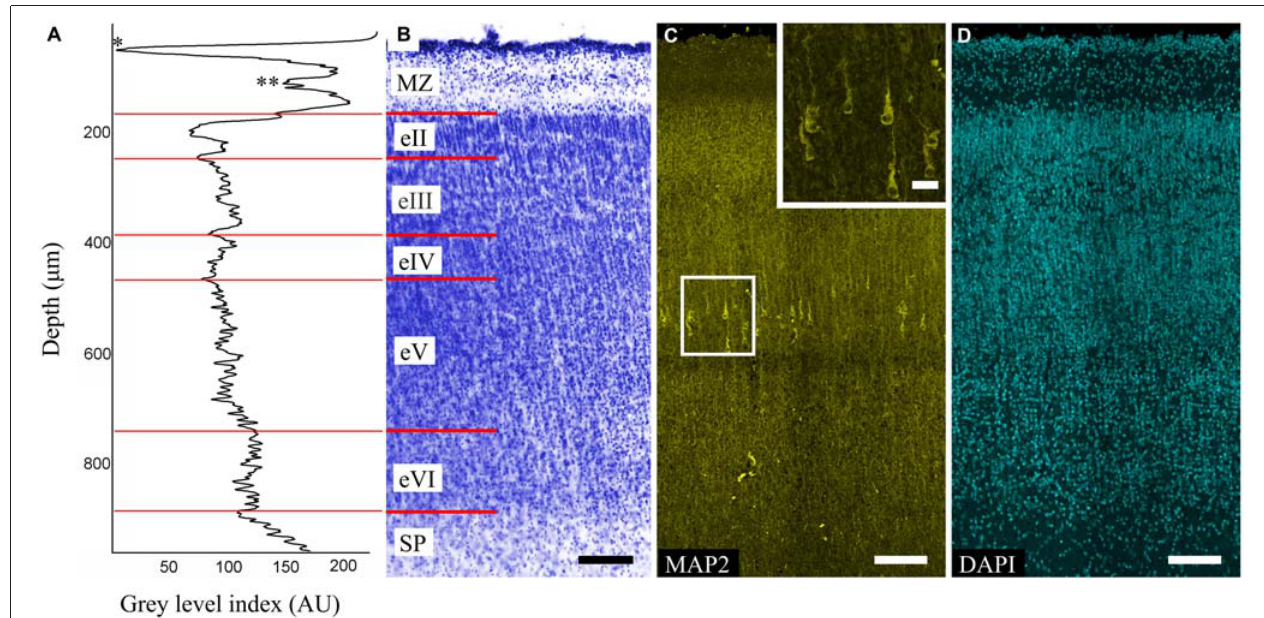
FIGURE 1 | Organization of the precentral gyrus at gestational week (GW) 26. (A) Gray level index (GLI) of the cortex layers ( ∗ ) subpial granular layer (SGL) of marginal zone (MZ). ( ∗∗ ) Deep granular layer (DGL) of MZ. The x -axis represents the relative cortical depth of a selected zone in µ m, and the y -axis represents the GLI values in arbitrary units in a range from 0 to 255. (B) Photomicrograph of a Nissl-stained paraffin section. Roman numerals indicate the layers of the cortical plate (CP). The red lines indicate the borders of each layer. (C) Photomicrograph of precentral gyrus FFPE section stained for microtubule-associated protein 2 (MAP2). Note the MAP2-positive pyramidal cells in layer eV. Box shows the position of the area given at a higher magnification in insert (D) 4 (cid:48) ,6-diamidino-2-phenylindole (DAPI) staining for anatomical reference. Scale bars: (B–D) 100 µ m, insert in (C) 20 µ